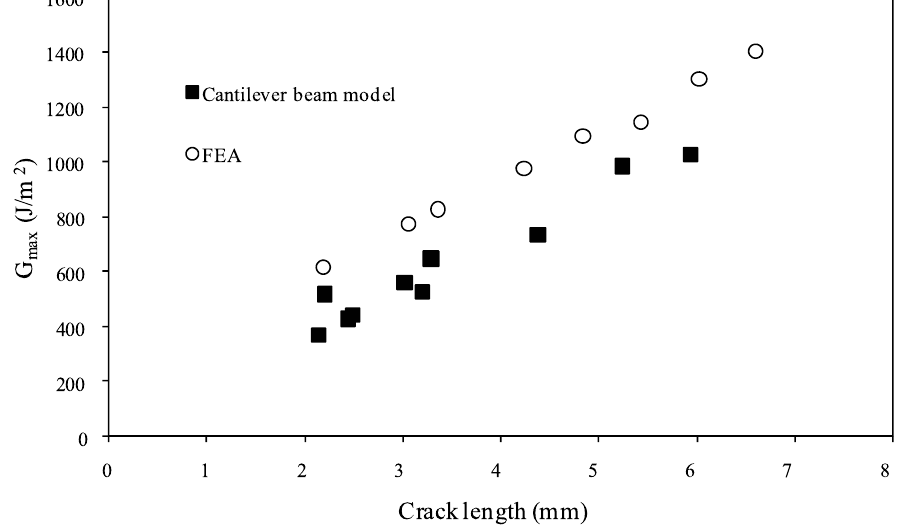
Fig. 11. Maximum dynamic strain energy release rate as a function of crack